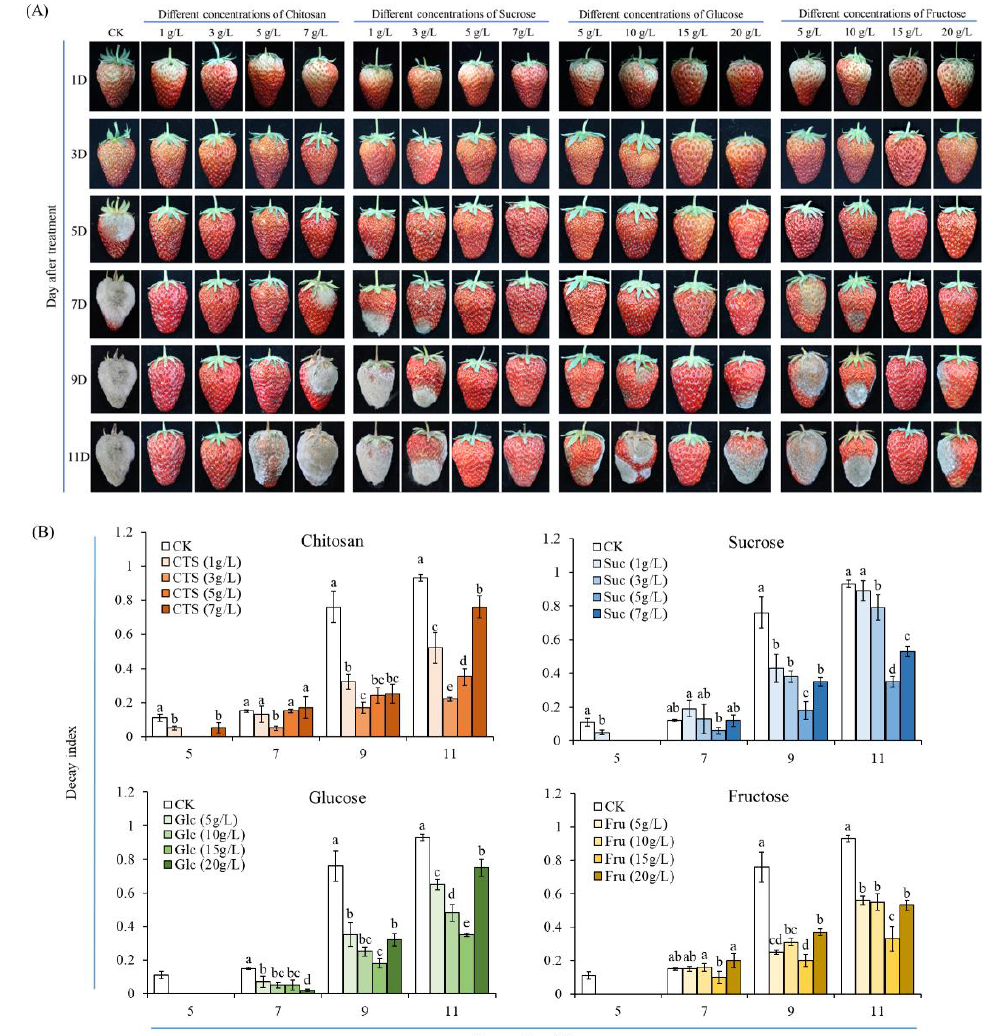
Figure 3. Effects of different sugar treatments on the ( A ) visual quality and ( B ) decay index of strawberry fruits stored at 15 ± 2 ◦ C for 11 d. Data are mean of three replicates. Different letters on top of bars in the same storage time indicate a significant difference (Tukey’s HSD test, p < 0.05). CK represents that strawberry fruits were immersed with water before storage; 1, 3, 5, 7 g/L CTS represents that strawberry fruits were immersed with 1, 3, 5, 7 g/L chitosan before storage, respectively; 1, 3, 5, 7 g/L Suc represents that strawberry fruits were immersed with 1, 3, 5, 7 g/L sucrose before storage, respectively; 5, 10, 15, 20 g/L Glc represents that strawberry fruits were immersed with 5, 10, 15, 20 g/L glucose before storage, respectively; 5, 10, 15, 20 g/L Fru represents that strawberry fruits were immersed with 5, 10, 15, 20 g/L fructose before storage, respectively; the same